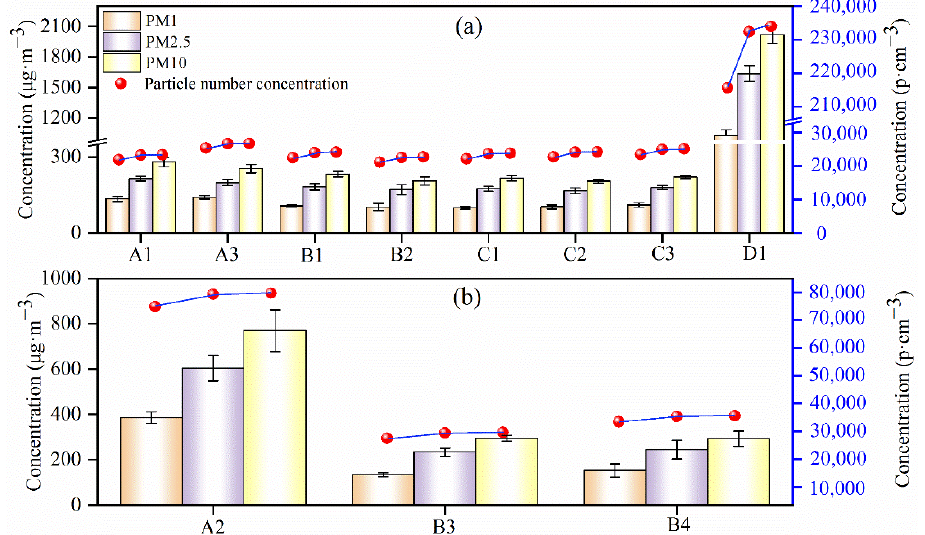
Figure 10. Average PM mass concentration and PNC in the plumes in dyeing process (( a ) panel) and printing process (( b ) panel, A2 represent pigment printing, B3 and B4 represent digital printing) of four textile dyeing enterprises (A, B, C, D).